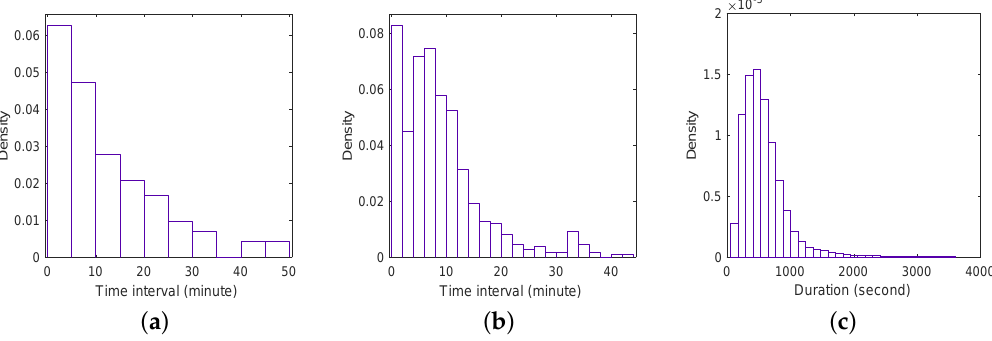
Figure 5. Statistical information of time interval and trip duration. ( a ) Rent; ( b ) Return; ( c ) Trip Duration. The trip duration is also an important parameter in the simulation system. As shown in Figure 5c, the distribution of trip duration obeys the lognormal distribution (the mean is 6.2806 and the sigma is 0.7032). In our simulation system, the trip duration of each trip is generated by this lognormal